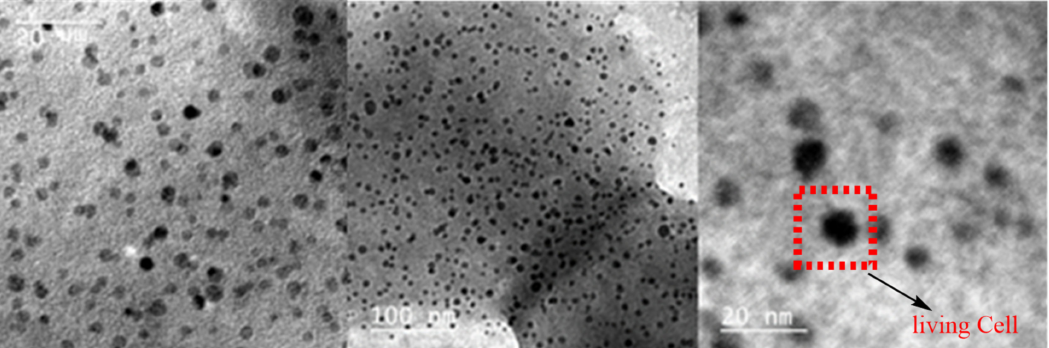
Figure 4. TEM micrographs of untreated methicillin-resistant Staphylococcus aureus ( MRSA ).